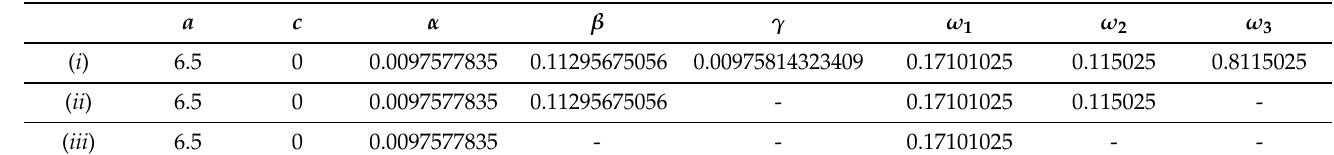
Table 6. The parameters used in Figures 8–11.